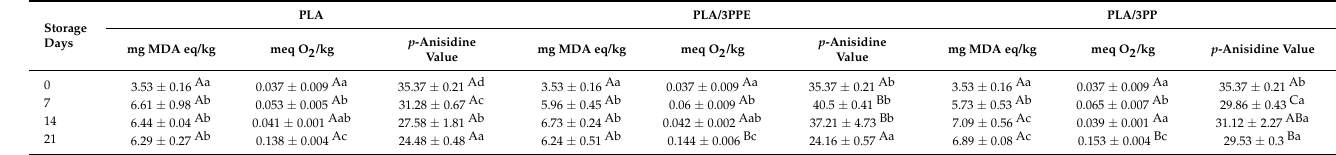
Table 8. Results of the TBARS assay, determination of the peroxide value, and the p-anisidine value of the almonds packaged with control and active PLA, stored at room temperature (23 ◦